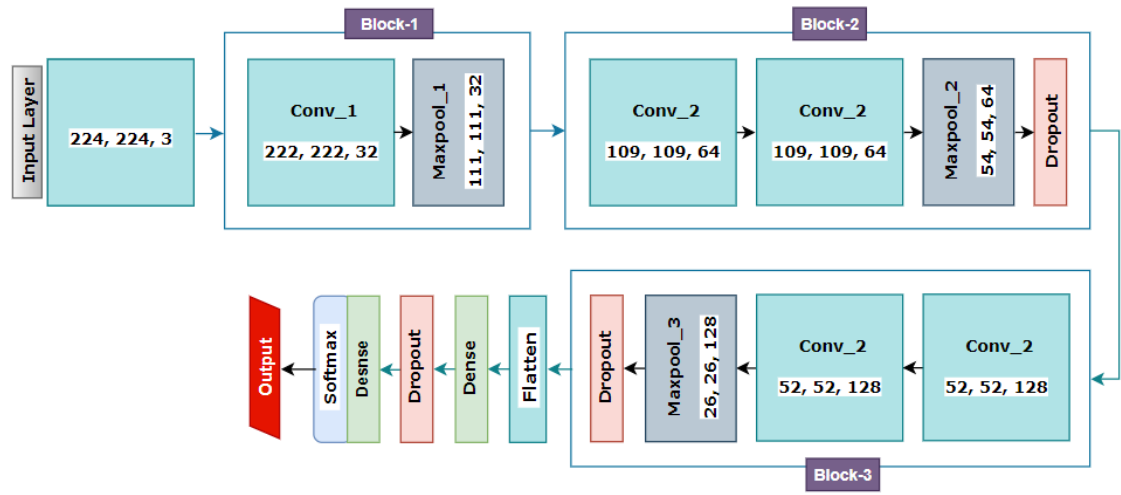
Figure 27. Proposed CNN model.